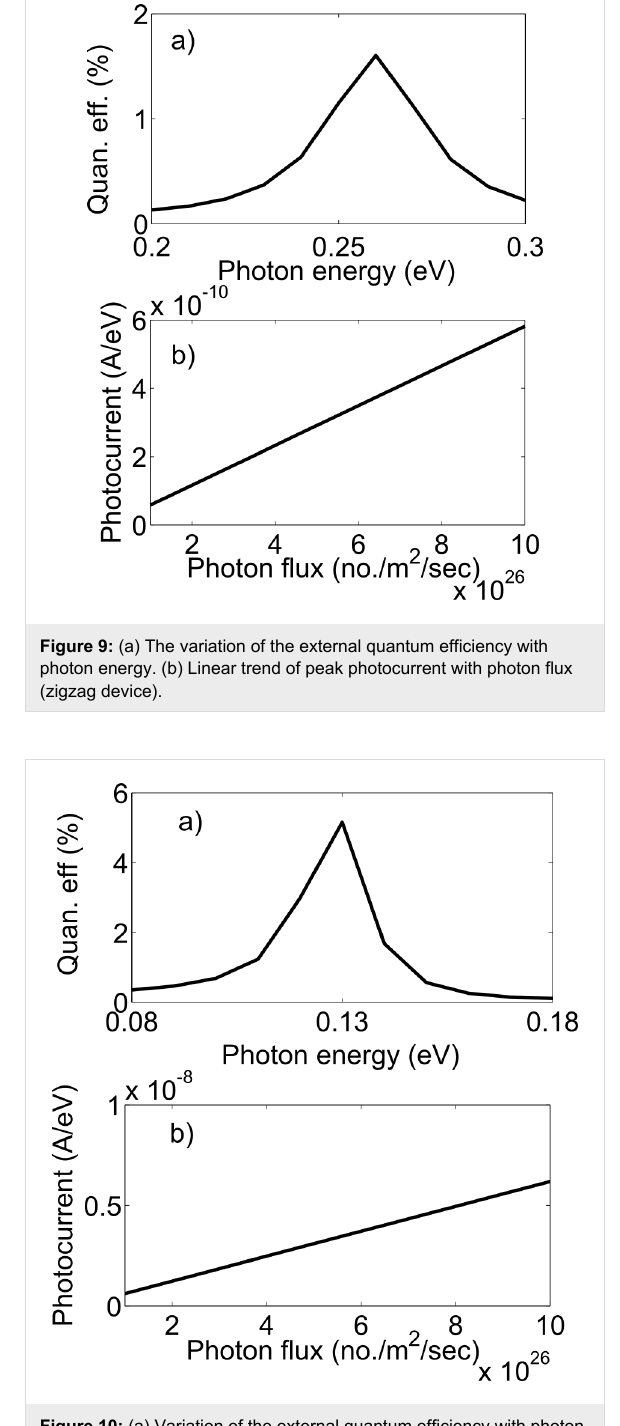
Figure 10: (a) Variation of the external quantum efficiency with photon energy. (b) Linear trend of the peak photocurrent with photon flux (armchair